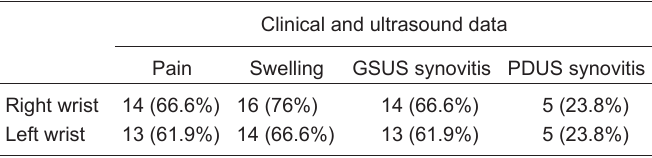
Table 2. Correlation between clinical and ultrasound examination. Clinical and ultrasound